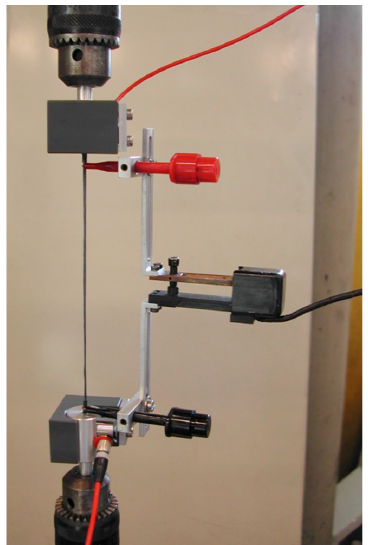
Figure 1. Tow test setup with extensometer clamped to the specimen and acoustic emission sensors on grips.